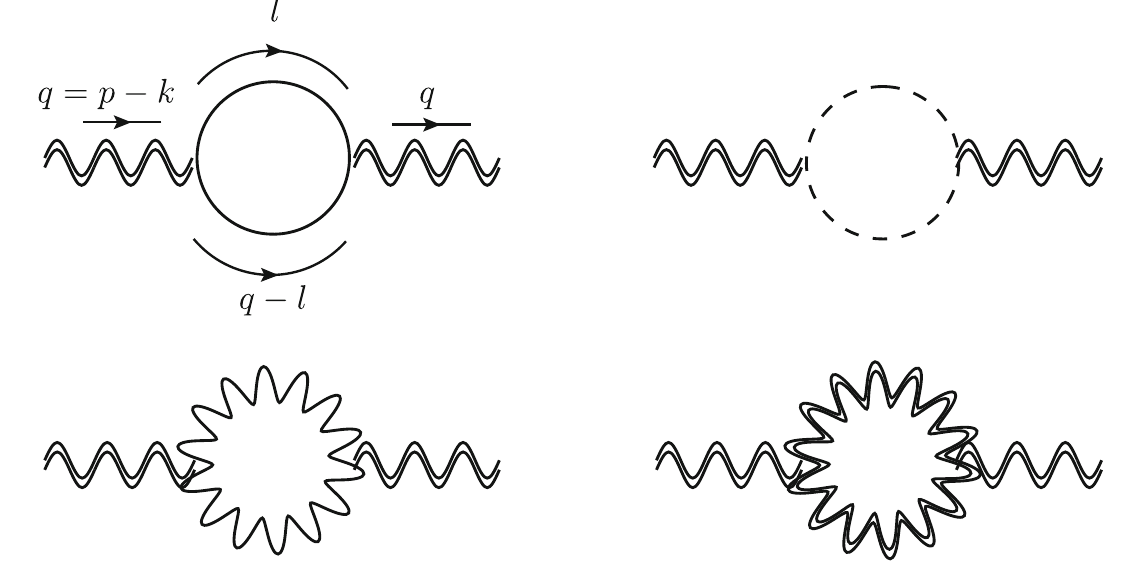
Fig. 2 The set of vacuum polarisations, Π , which modify the bare graviton propagator is represented by the double wavy lines. The solid line (dotted) indicates a Dirac fermion (minimal scalar) field and the wavy (double wavy) indicates a gauge boson (graviton). The external arrows indicate the momentum